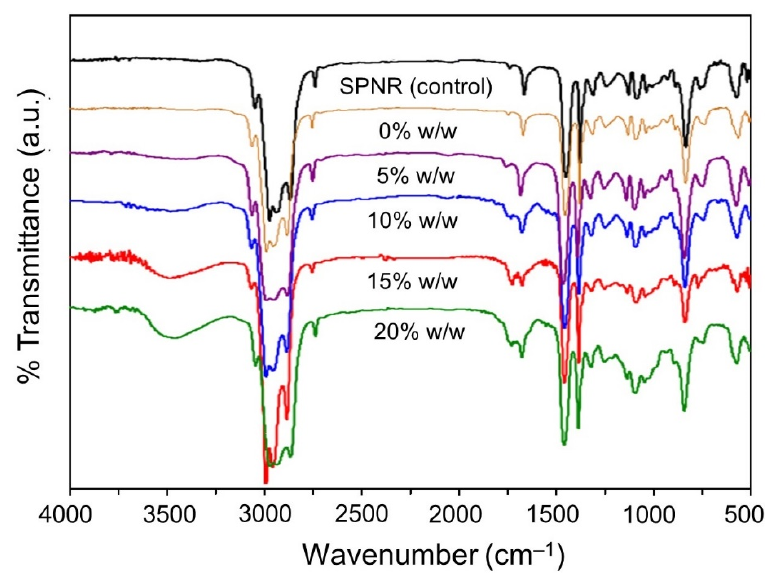
Figure 7. FTIR spectra of SPNR and the samples prepared by introducing 2.0 phr of TiO 2 powder with various H 2 O 2 concentrations after UVC-irradiation for 5 h.